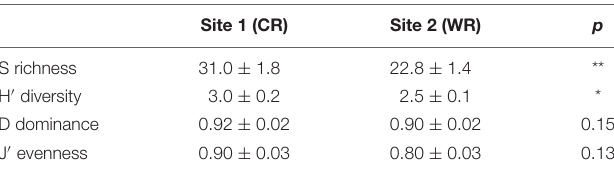
TABLE 2 | Average ( ± SE) species richness (S), Shannon diversity (H (cid:48) ), Simpson dominance (D) and Pielou’s evenness (J) between Cape Recife (CR) and Willows Resort